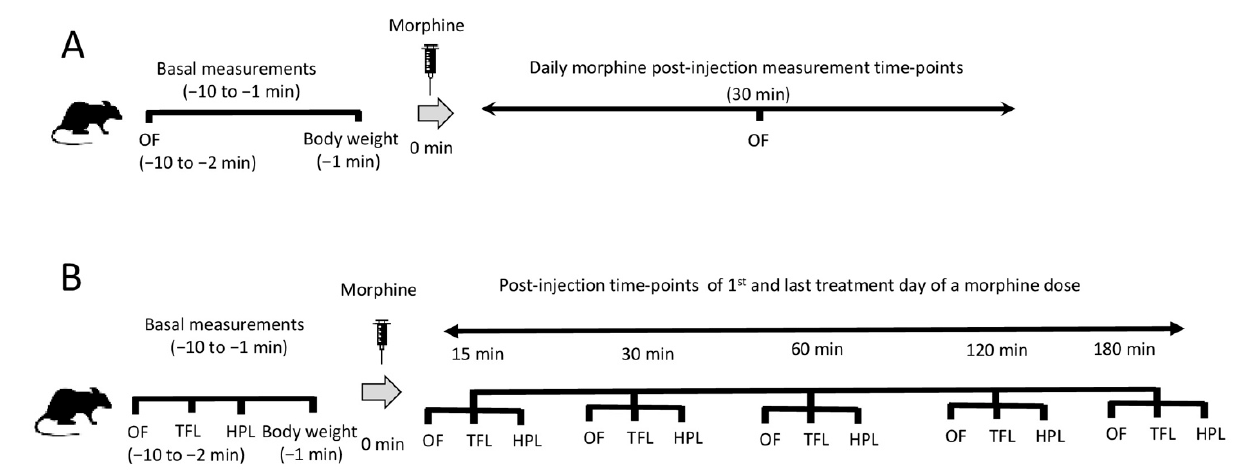
Figure 6. Schematic representation of the morphine treatment as well as behavioral and antinociception assessments used in the study. Animals were treated daily for baseline behavior (pre-) and 30 min post-administration of morphine ( A ), or pre- and post- (15, 30, 60, 120 and 180 min) administration of morphine on the first and the last treatment day of a morphine dose ( B ). The main assessment of motor behavior was calculated using data from open-field tests (OF). Antinociception was followed in order to validate the effect of morphine on the animals and be able to relate morphine’s antinociceptive effect with the produced motor behaviors after repeated drug administrations. Antinociception assessment was performed using tail-flick (TFL) and hot-plate (HPL) tests.